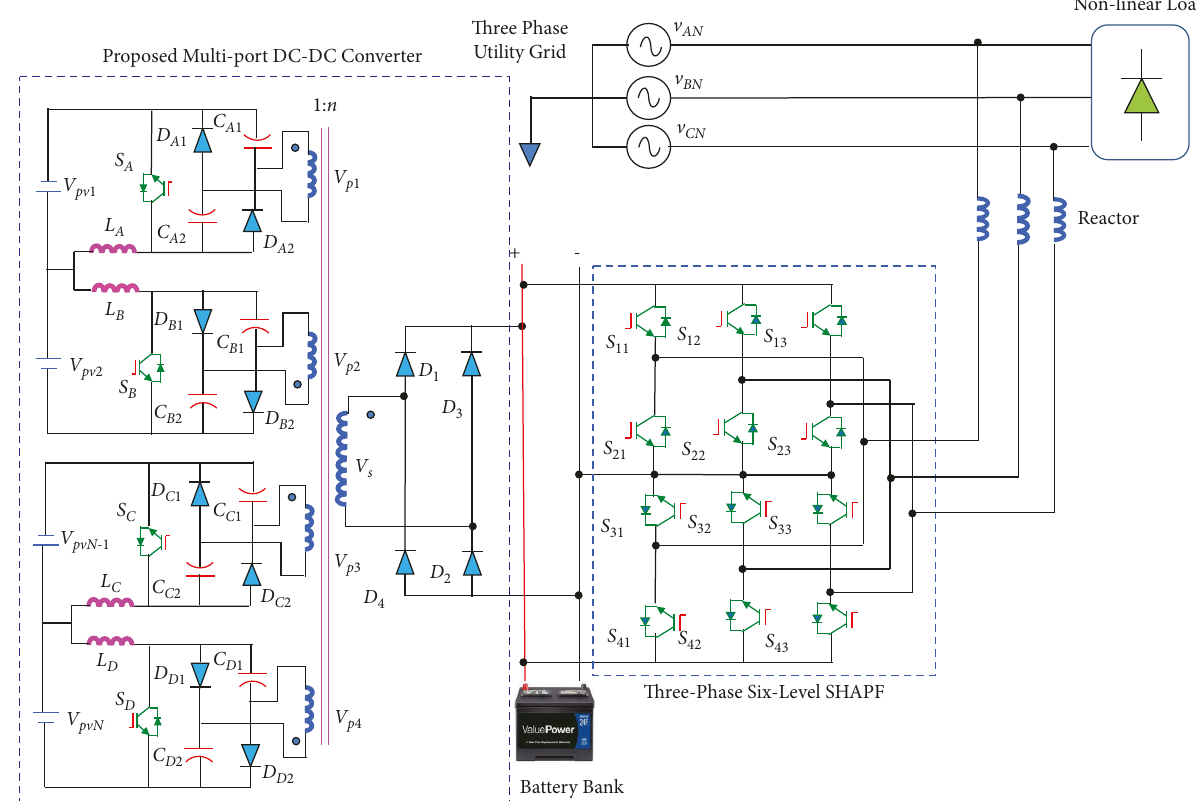
Figure 3: Power circuit of the proposed N- port interleaved flyback converter fed